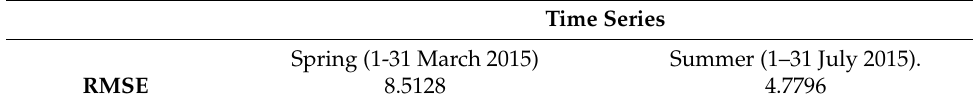
Figure 7. Wind speed prediction of proposed LSTM for Summer (July 2015) data: ( a ) Comparison of observed values and forecast values; ( b ) Error and RMSE value values. Table 1. Evaluation of two different time series data in the LSTM model.